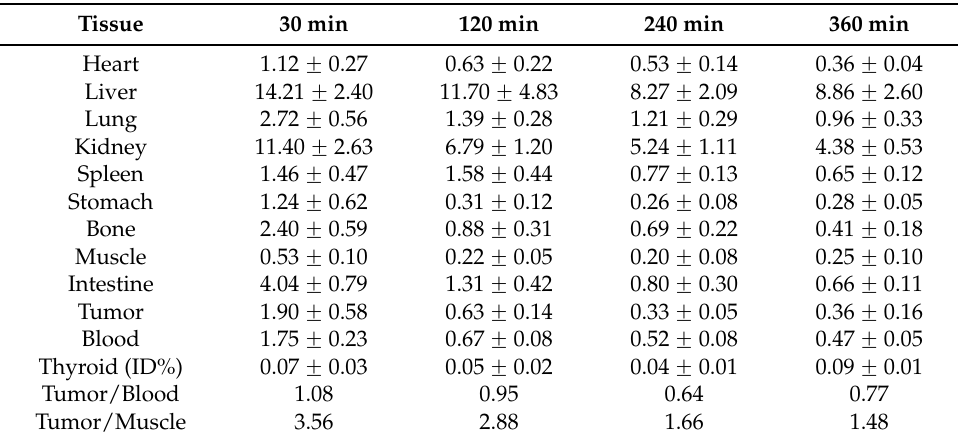
Table 4. Biodistribution of 7d in mice bearing S180 tumor (mean ˘ SD, n = 4, %ID/g).